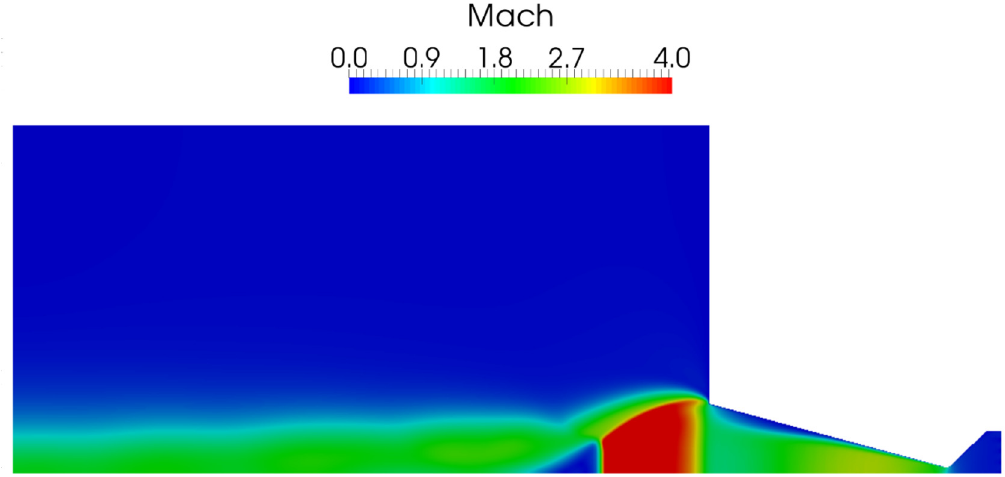
Figure 5. Contour plot of the Mach number for the baseline configuration of the nitrogen gaseous flow (test case N2_1). Table 7. Performance analysis of the micro-nozzle: water vapor flow.